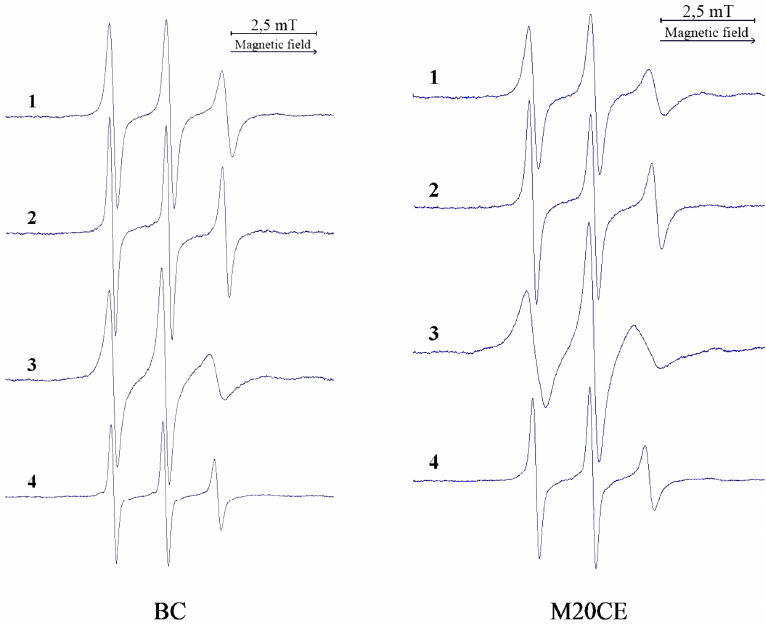
Fig. 14. EPR spectra of the spin probes in 1 % aqueous solutions of surfactants at 25 °С: 1 – TEMPO-iodide; 2 – 4-palmitamido-TEMPO; 3 – 5-DSA; 4 –